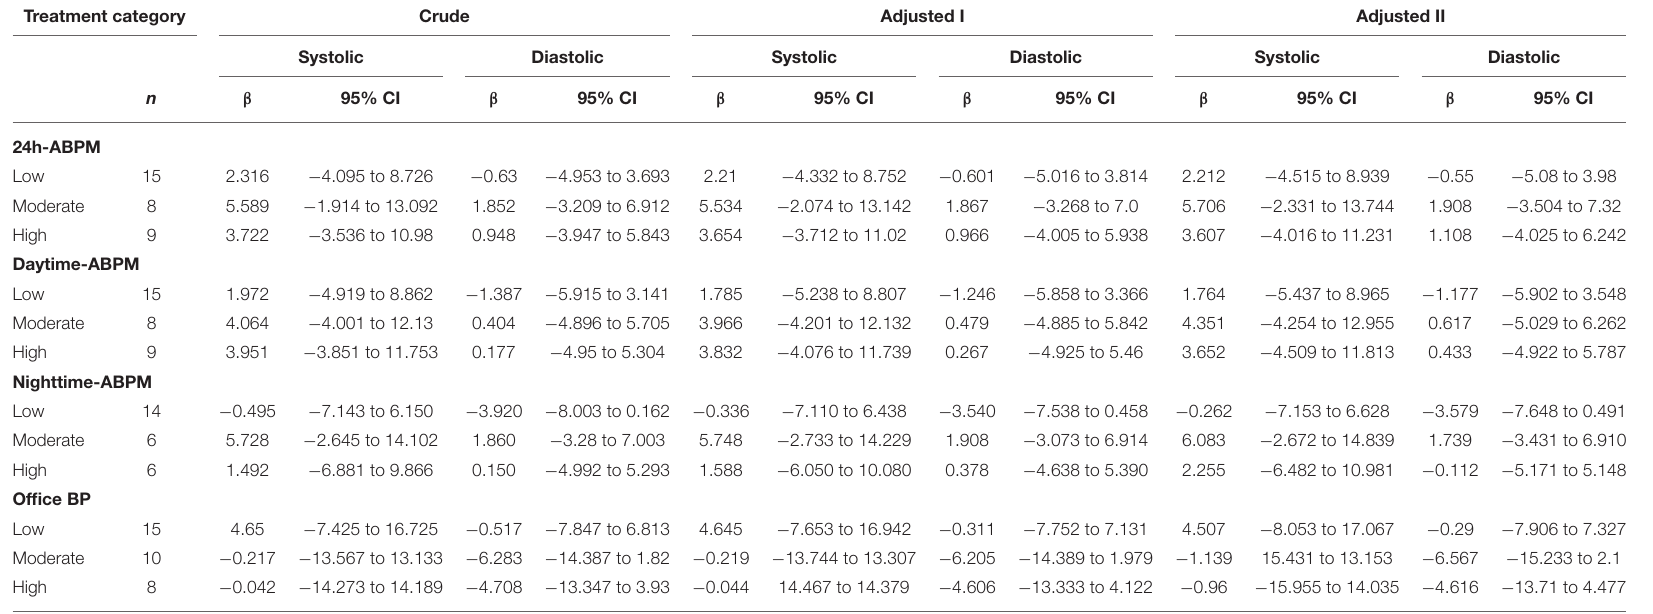
TABLE 3C | Association of systolic and diastolic blood pressure change (mmHg) with respect to treatment category (low, moderate, high; reference, none). Treatment category Crude Adjusted I Adjusted II Systolic Diastolic Systolic Diastolic Systolic